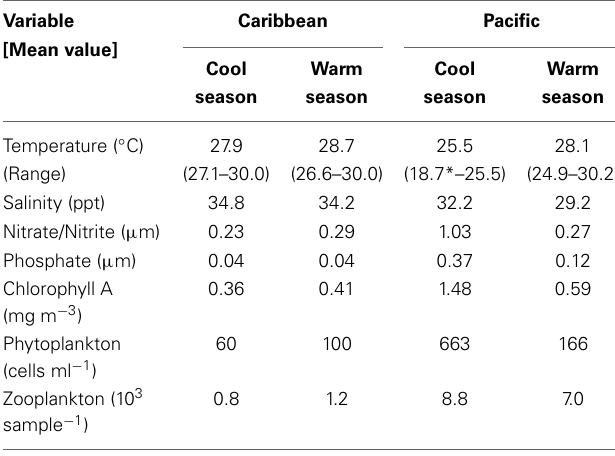
Table 1 | Variation in oceanographic conditions on the Caribbean and Pacific coasts of Panama where we collected fish eggs for this study.